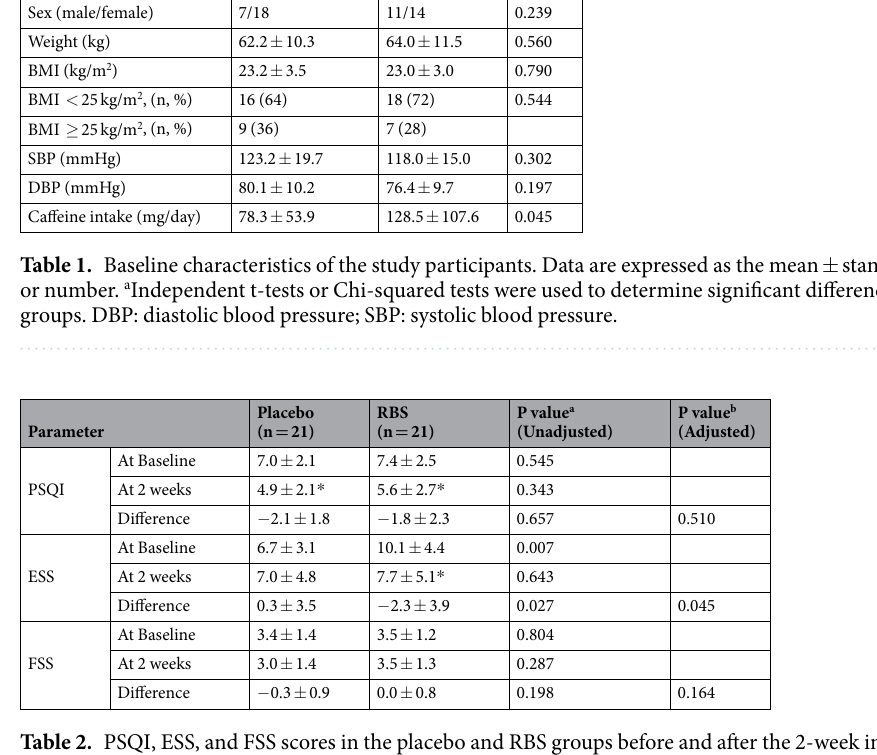
Table 2. PSQI, ESS, and FSS scores in the placebo and RBS groups before and after the 2-week intervention. Data are expressed as the mean ± standard deviation. * Within-group comparison, paired t-test, P < 0.05. a P values refer to independent t-tests, compared with the placebo group. b P values are for the analysis of covariance; adjusted for caffeine intake as a covariate. PSQI scores, with higher scores indicate worse sleep quality. ESS scores, higher scores indicate greater sleepiness. FSS scores, higher scores indicate more fatigue